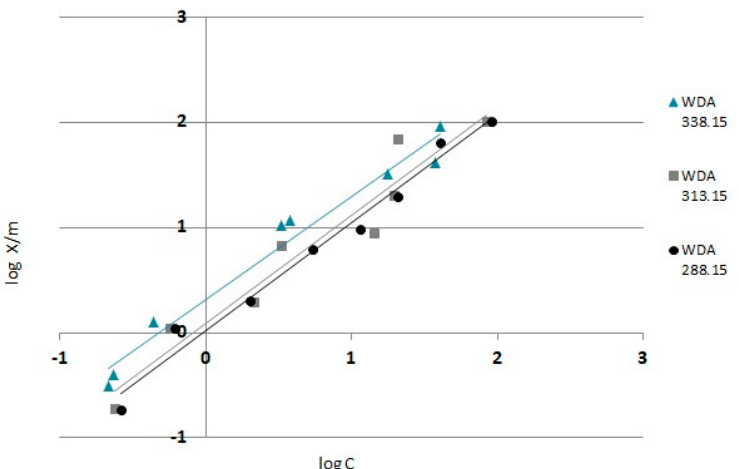
Figure 4. Freudlich adsorption isotherms for WDA, at temperatures: 288.15; 313.15; 338.15 [K].